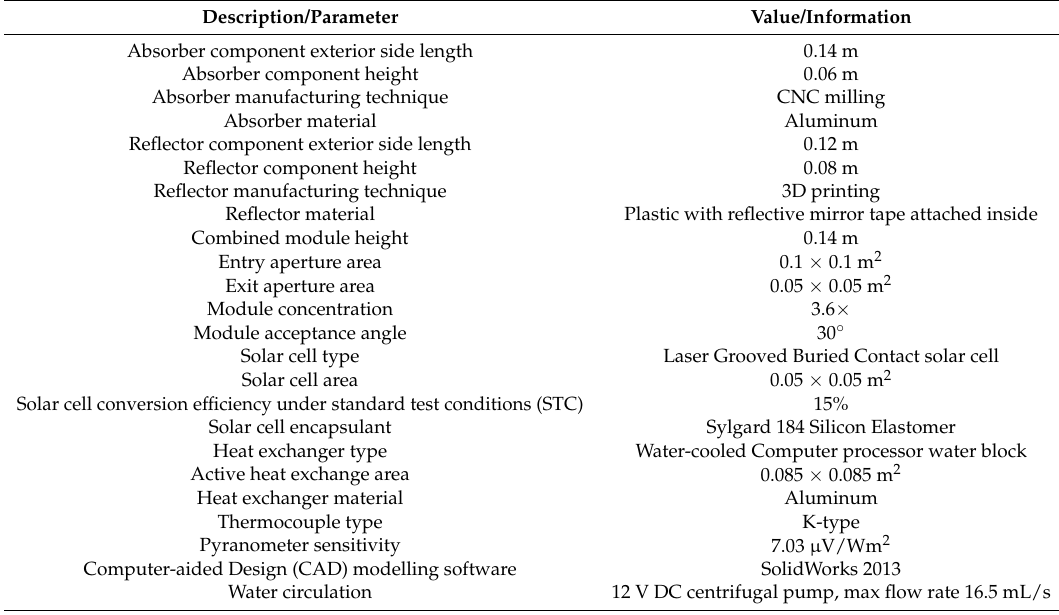
Table 1. General design and material information about the